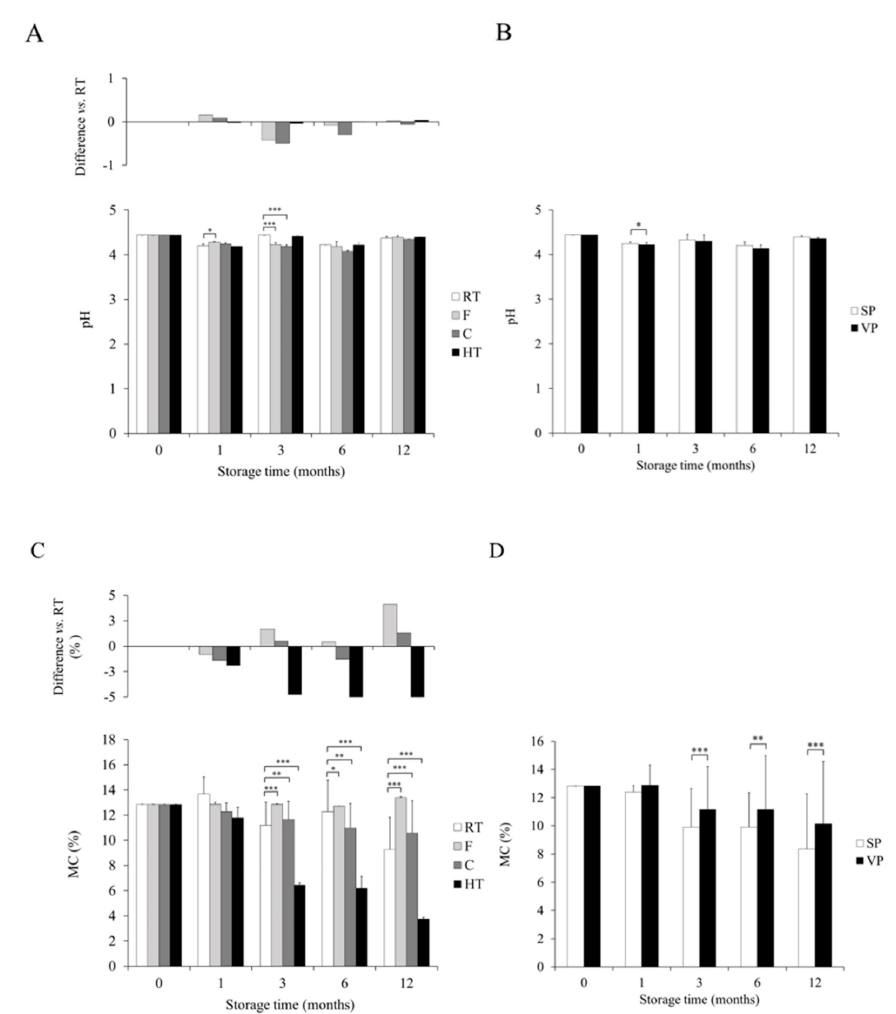
Figure 2. Effect of storage temperature and packaging mode on pH ( A , B ) and moisture content (MC) (%) ( C , D ) in fermented food product (FFP) samples. RT: room temperature; F: freezing; C: